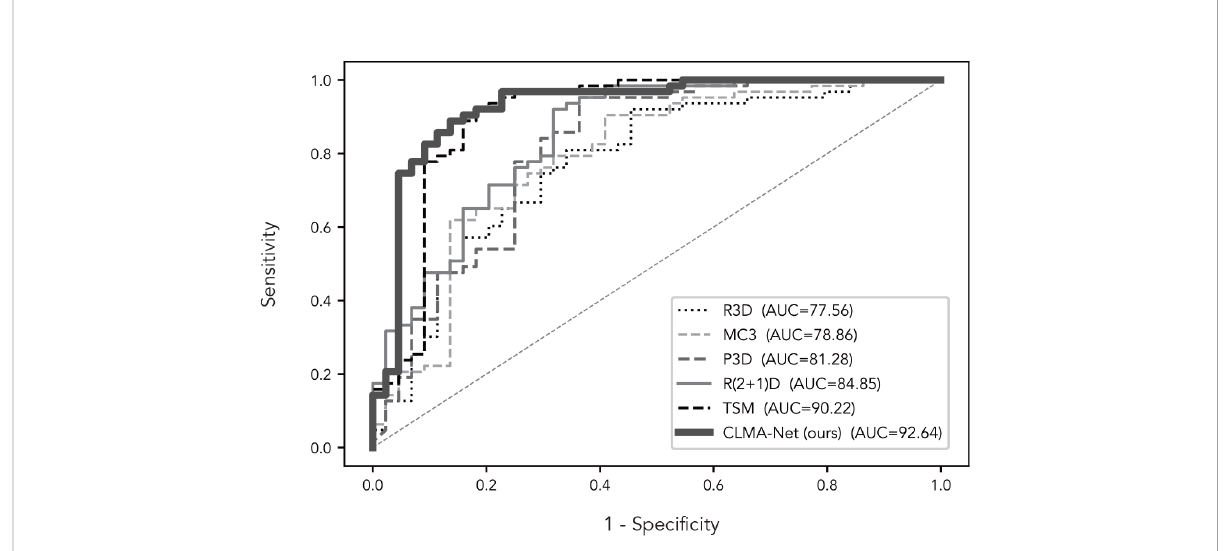
FIGURE 5 ROC curves of our network and compared methods.